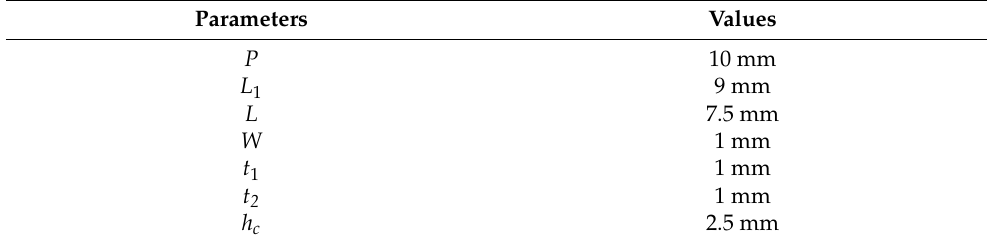
Table 2. PRS structure